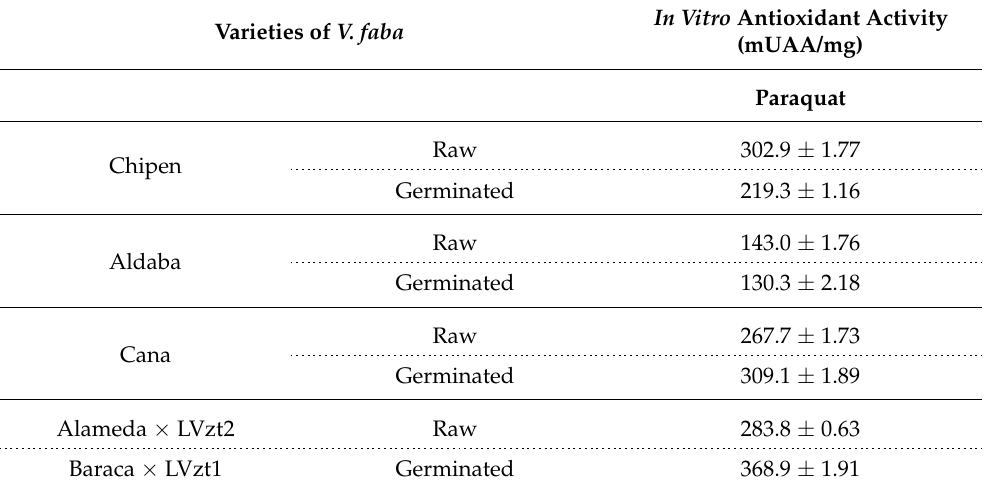
Table 4. Antioxidant capacity of the protein hydrolysates from different V. faba varieties (raw and germinated flour) tested in HT-29 cell